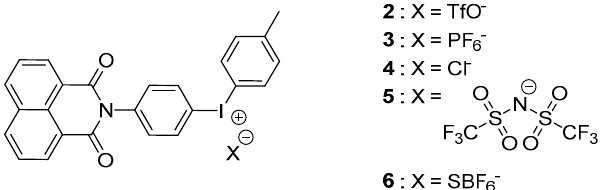
Figure 1. Chemical structures of the different iodonium salts 2 – 6 .